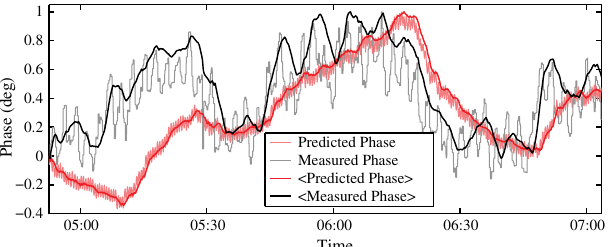
FIG. 6. Estimation of the rf phase in the first ten sectors of the linac using L i T rack ES compared to the vector sum of klystron